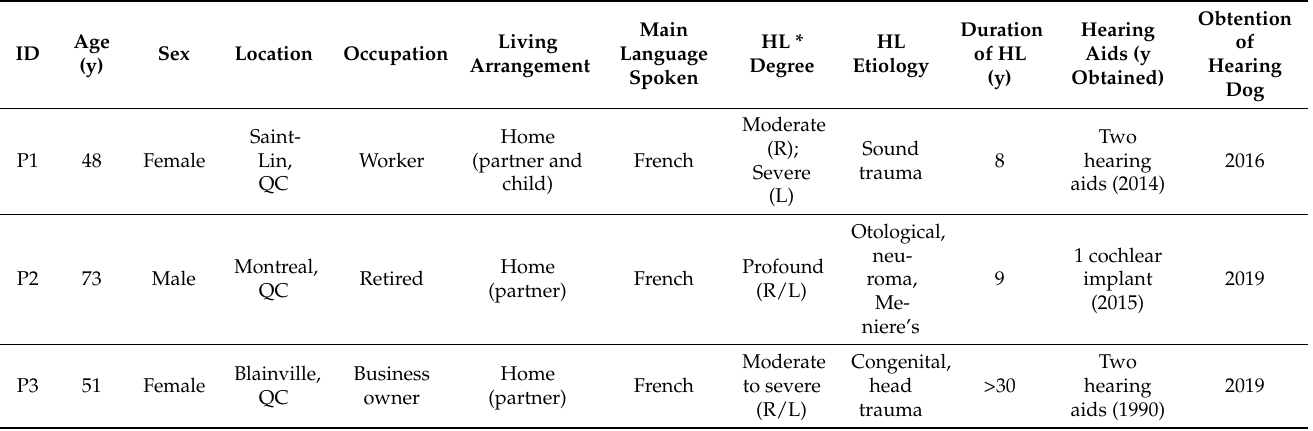
Table 1. Participants characteristics ( n =